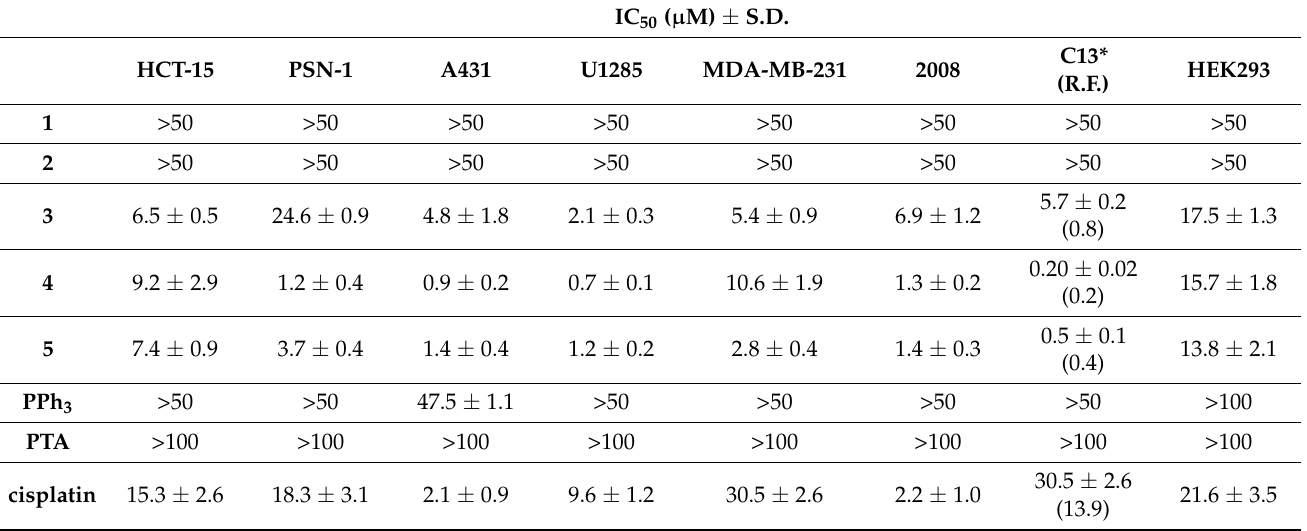
Table 1. Cytotoxicity of ligands 1 and 2 , coligands PPh 3 and PTA, newly developed silver(I) complexes 3 – 5 and cisplatin on 2D cell